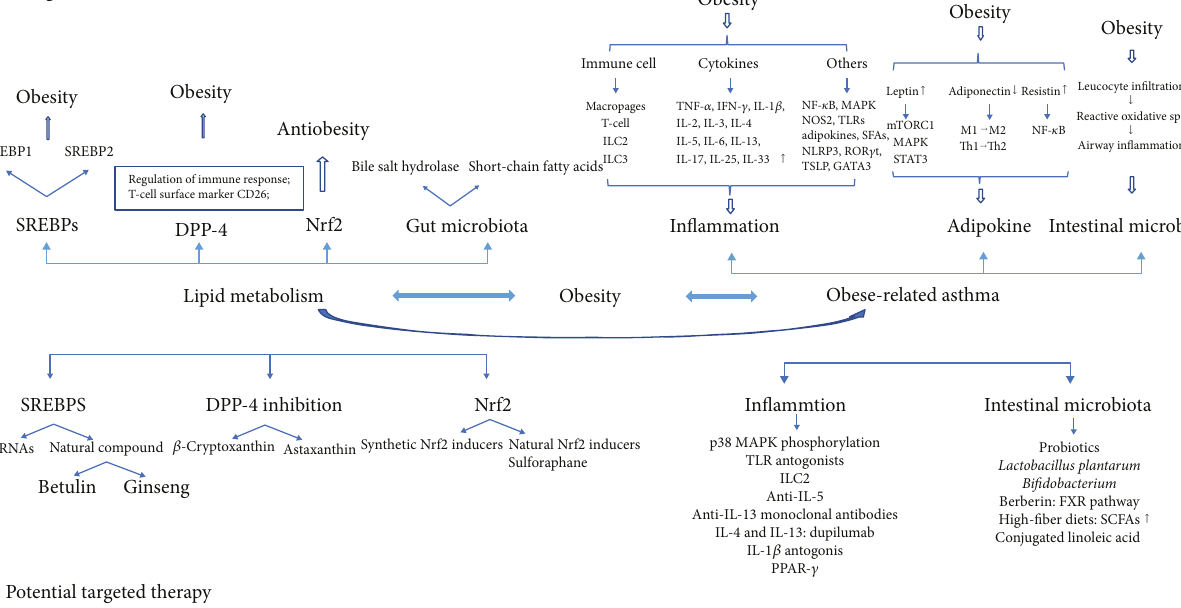
Figure 1: Possible connections among lipid metabolism, obesity, and obesity-related asthma. This fi gure is divided into two parts: the upper part about pathogenesis and the lower part about potential targeted therapy. The part on pathogenesis demonstrates a few major e ff ects of immune regulators. The other introduces the corresponding possible targeted therapy including SREBPs, miRNAs, and the DPP-4